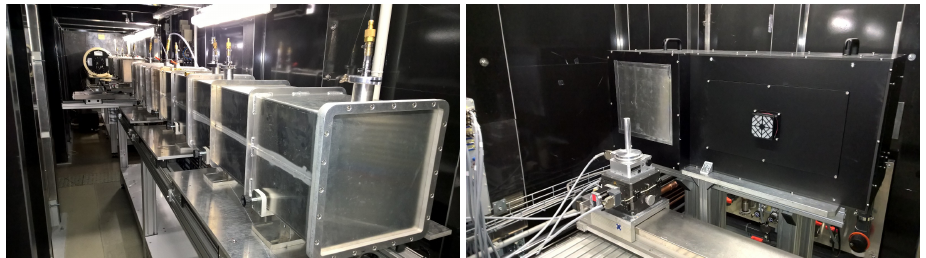
Figure 1: View of V7. Flight path equipped with containers filled with He gas for loss free transport of the neutron beam to the sample position (left). Sample position equipped with translation, tilt and rotation stages. The detector box with active area of 30 cm x 30 cm is behind the sample stage (right). 2